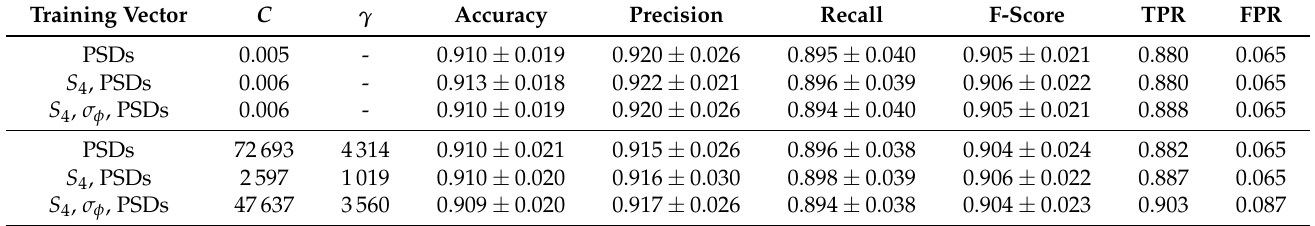
Table 4. Performance overview combining amplitude and phase features.